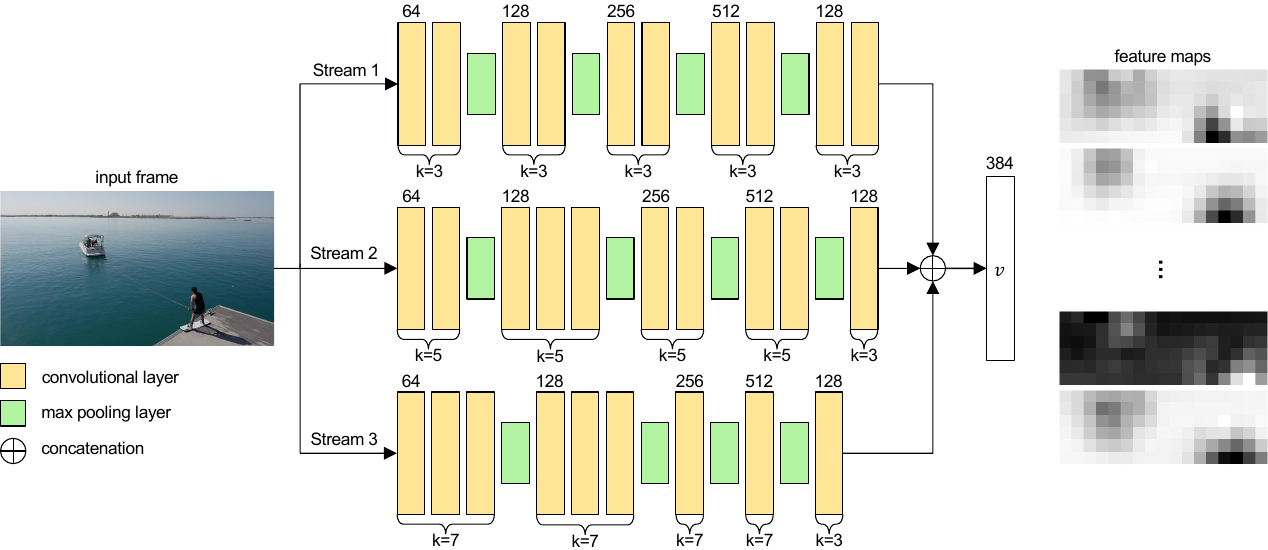
Figure 3. Detailed multi-stream CNN implementation. Each stream employs a different kernel size to analyze different image characteristics along the stream. A filter bottleneck is applied to all streams to reduce the number of